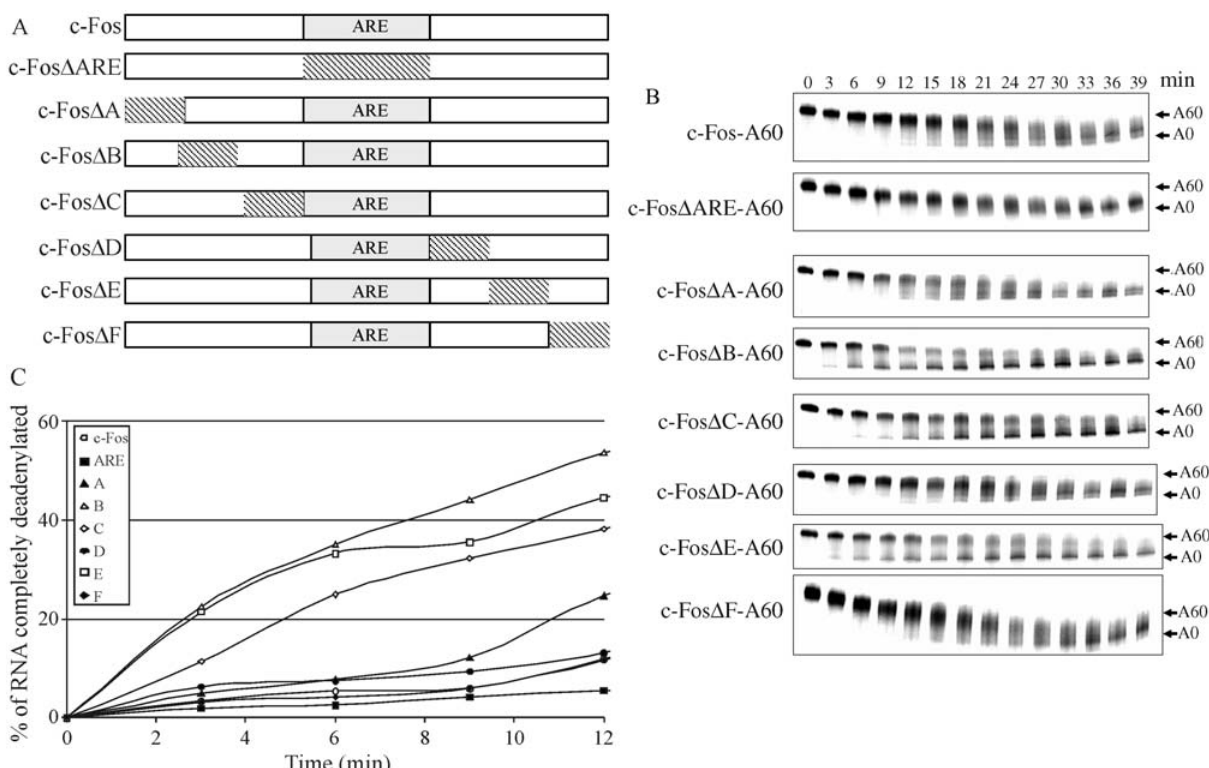
Figure 3 - Deletion of specific regions outside the AU-rich element significantly alters the deadenylation pattern of the cFos-A60 RNA substrate. Panel A. Diagrammatic representation of the RNAs used in the assays. Deletion constructs were made by a PCR approach using specific primers to generate the indicated variants. Panel B. Capped and polyadenylated RNAs containing the deletions outlined in panel A were incubated in HeLa extracts in the in vitro deadenylation/decay system for the times indicated. Reaction products were analyzed on 4% acrylamide gels containing 7 M urea and visualized by phosphorimaging.Thepositionsoftheadenylated(A60)andunadenylated(A0)RNAsareindicatedtotheleft.Arrowsonthelefthighlightthethreevari- ants that demonstrated a fast/asynchronous pattern of deadenylation. Panel C. Graphical representation of the data presented in Panel